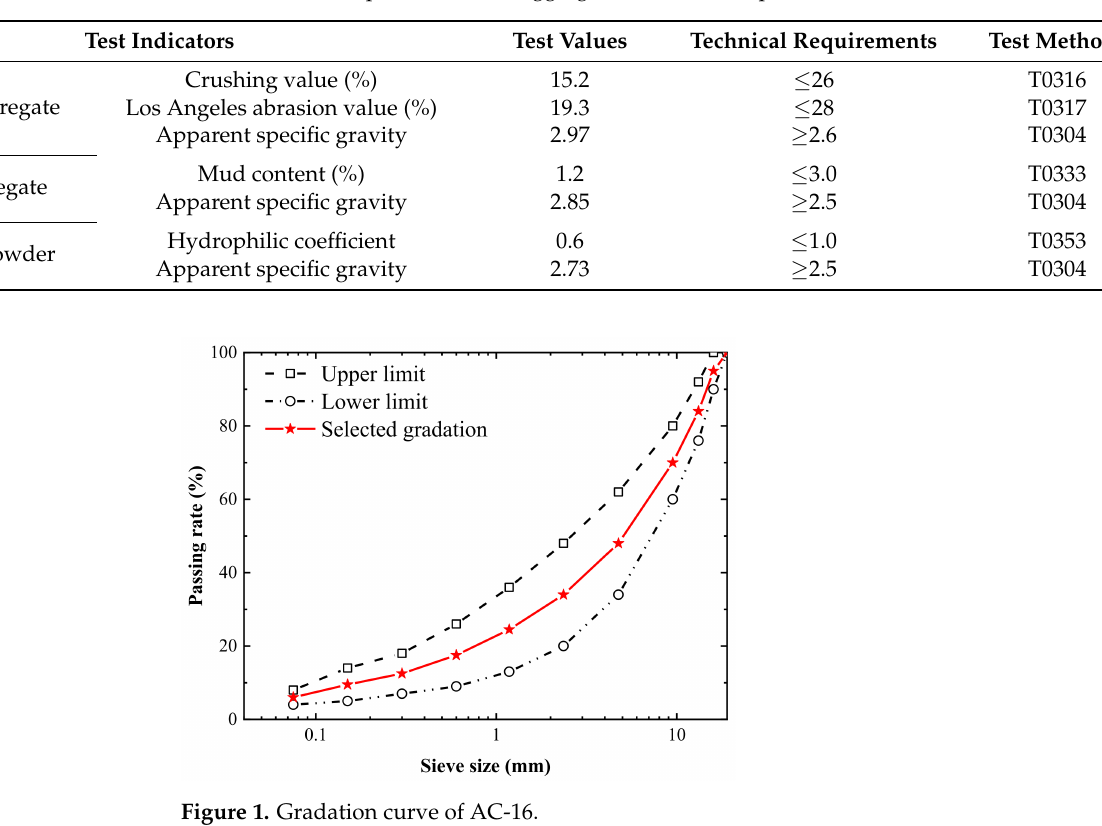
Table 2. Technical specifications of aggregates and mineral powder.